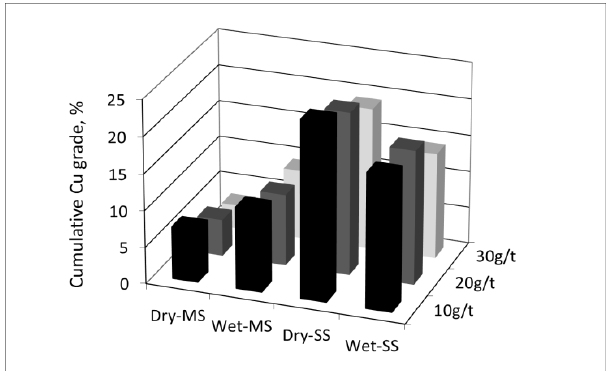
Figure 8. Pyrite vs. water recovery in flotation after milling conditions of ( a ) Wet-SS ( b ) Wet-MS ( c ) Dry-SS ( d ) Dry-MS.